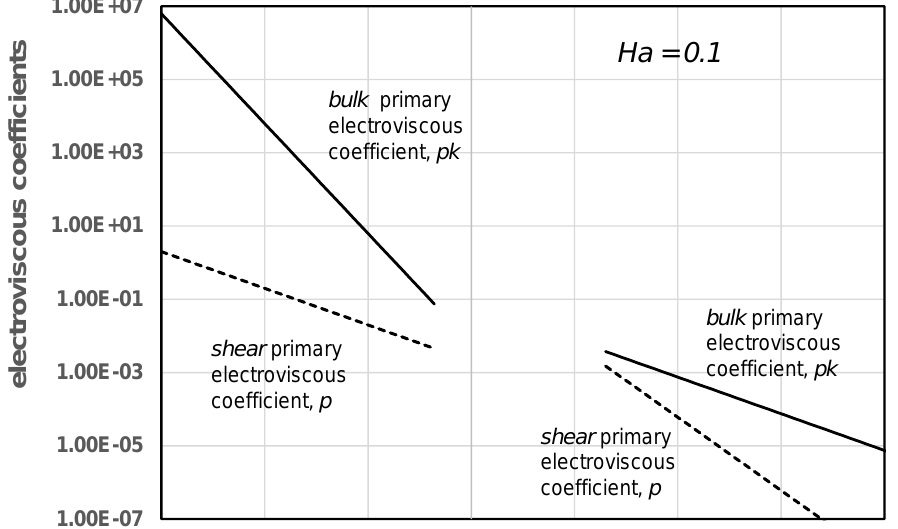
Figure 10. Comparison of bulk and shear primary electroviscous coefficients at a small Hartmann number of 0.1.